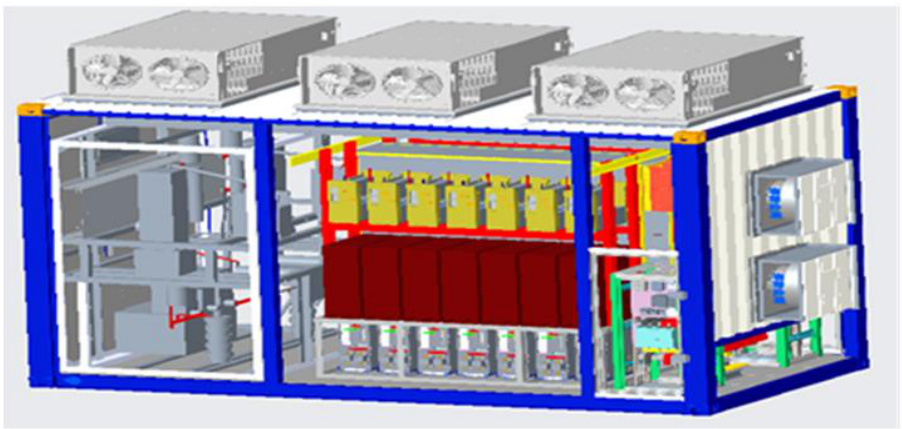
Figure 23. The design layout of the DC/DC converter.